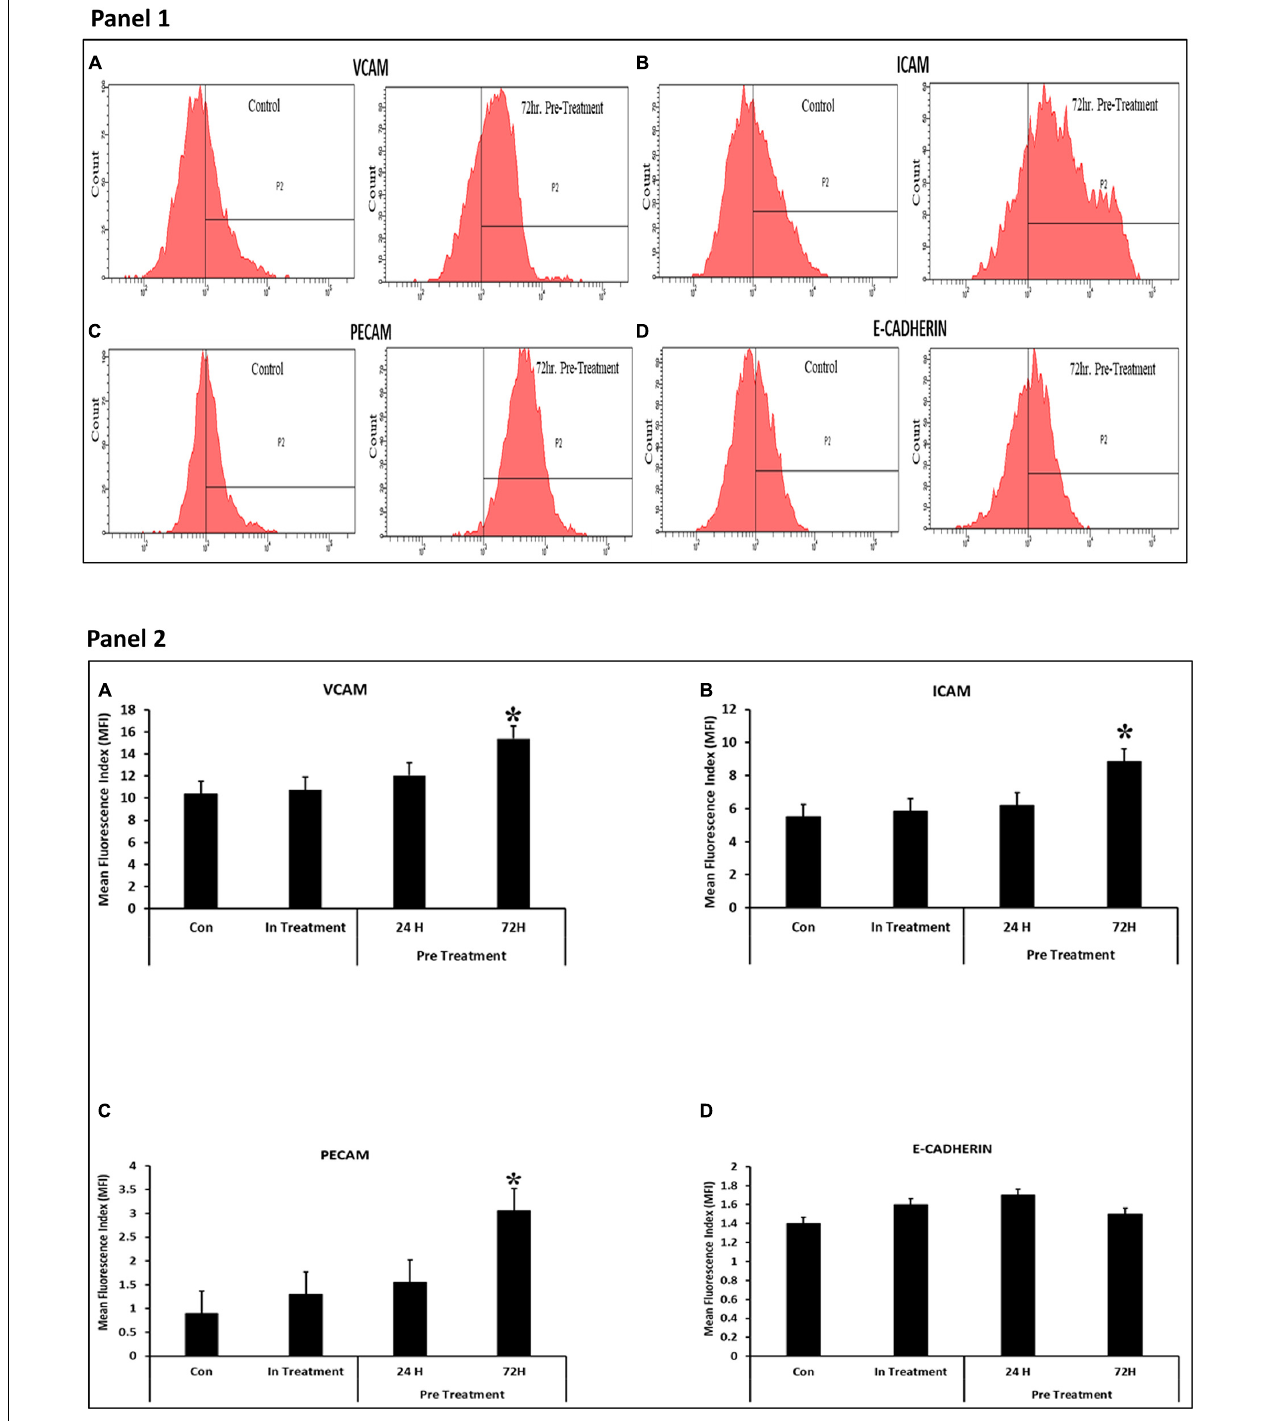
FIGURE 7 | Effect of CM-MDA231 on CV-MSCs expression of Adhesion molecules. Flow cytometry analysis of the adhesion molecules performed on preconditioned, in-treatment, and untreated CV-MSCs showed that there was significant increase in the expression levels for VCAM, ICAM1 and PECAM, after preconditioning them for 72 h (A–C) , but no changes in the expression levels were observed in cells preconditioned for 24 h, in-treatment and untreated controls. No significant changes in expression levels was observed for E-Cadherin (D) between the preconditioned, in-treatment and untreated controls (Panel 1). The data obtained by FACS from five independent experiments was quantified. The average is presented as bar diagrams in panel 2. VCAM is represented as (A) , ICAM1 as (B) , PECAM as (C) and E-Cadherin as (D) in panel 2, respectively. Bars represent standard errors * P ≤ 0.05.